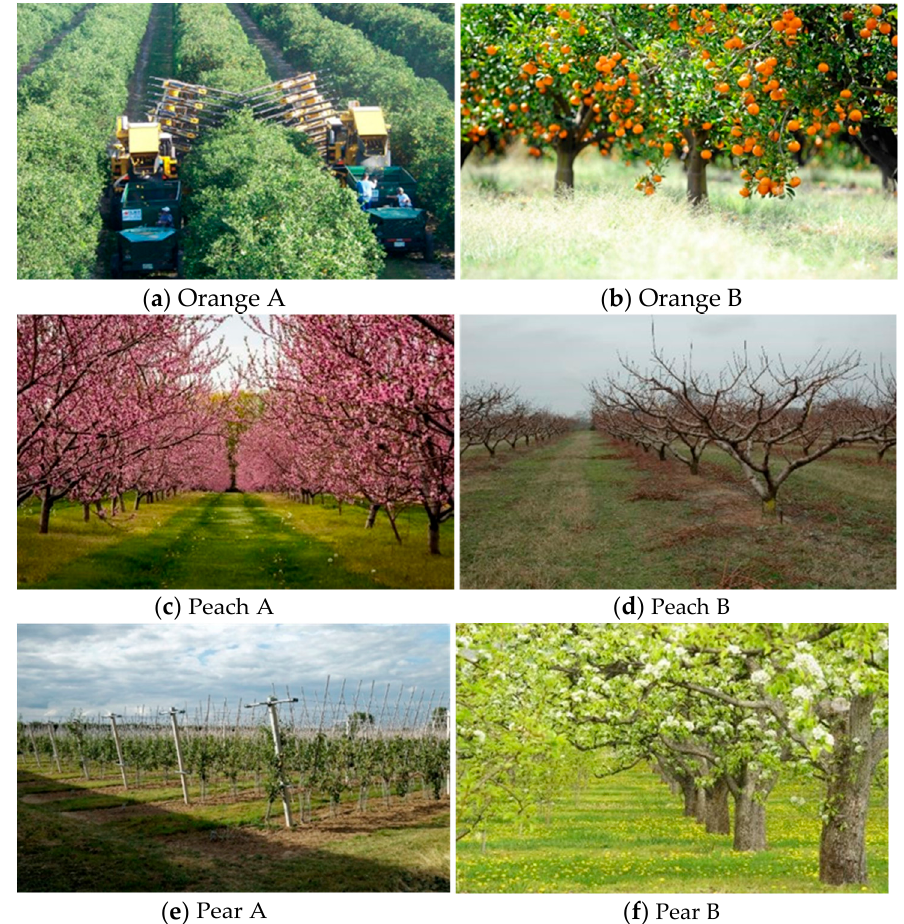
Figure 1. Photos submitted to the participants representing the landscape where the fruit used to produce the tasted juices was obtained.